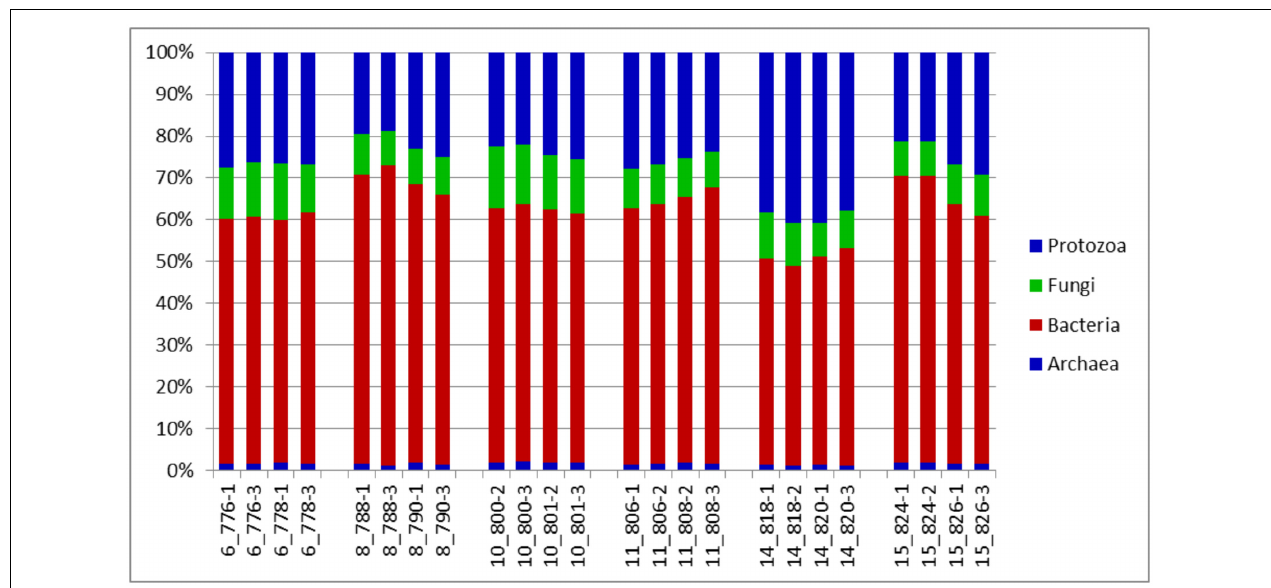
FIGURE 1 | Distributions of phyla (relative abundances), for the total rRNA analyses of solid-phase rumen contents of 6 cattle, 2 samples from each, analyzed in duplicates. The leading numbers 6 ... 15 refer to the animal